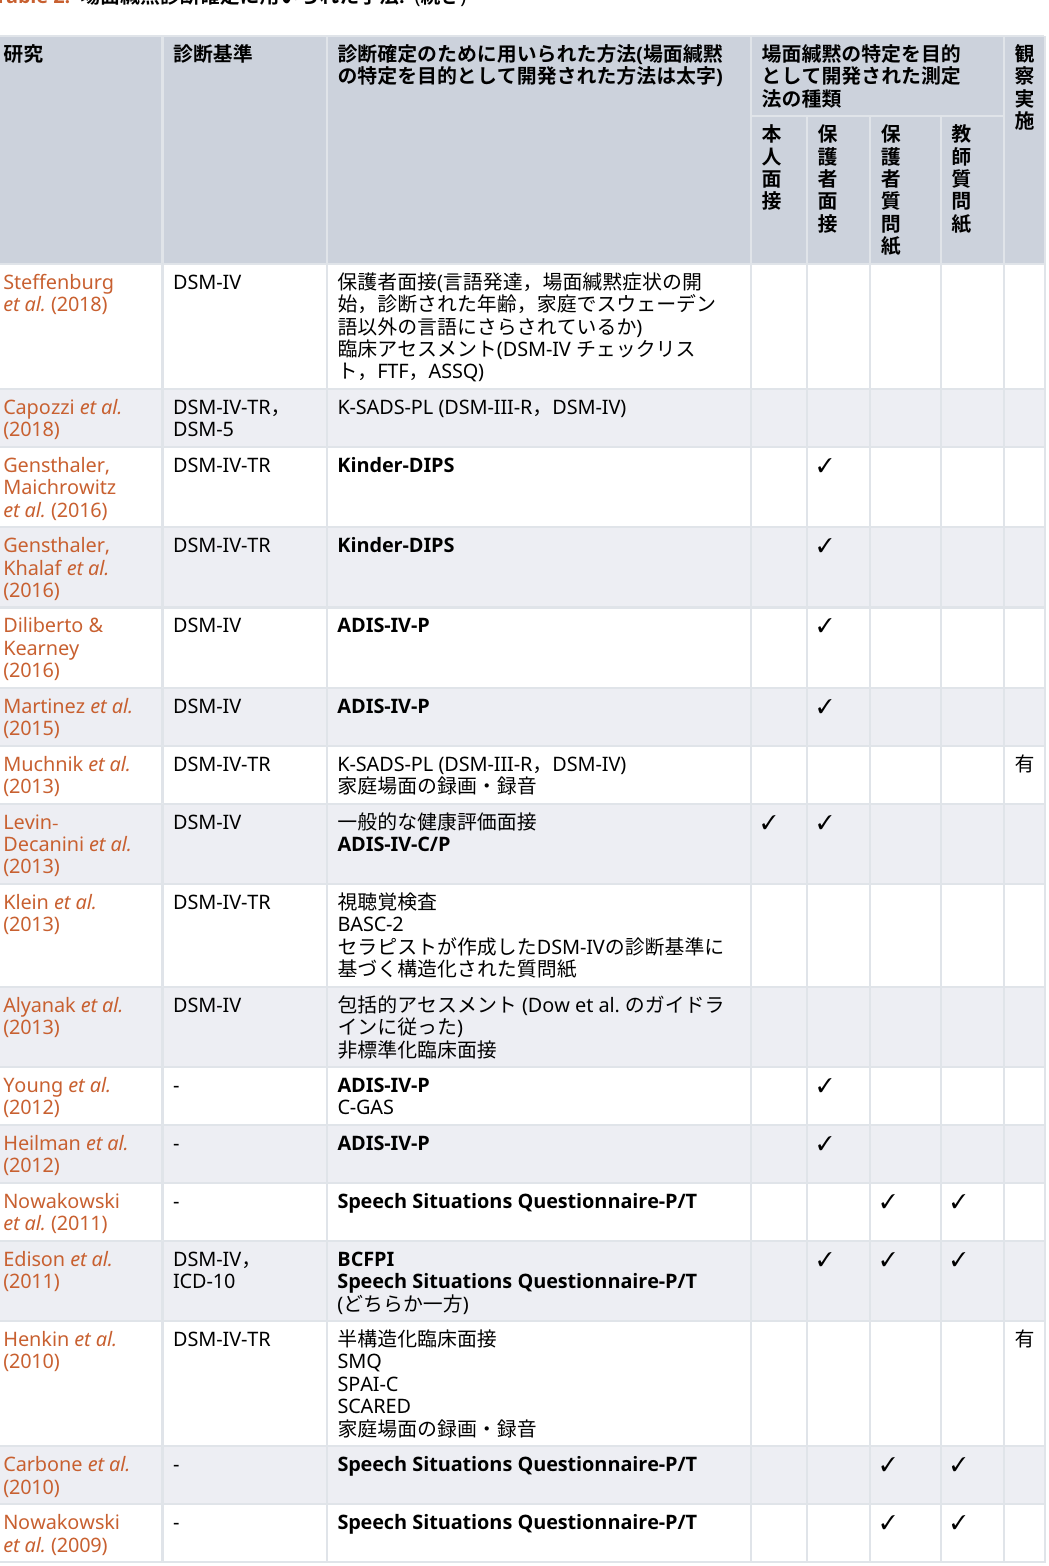
Table 2. 場 面 緘 黙 診 断 確 定 に 用 いられた 手 法 . ( 続 き ) 研 究 診 断 基